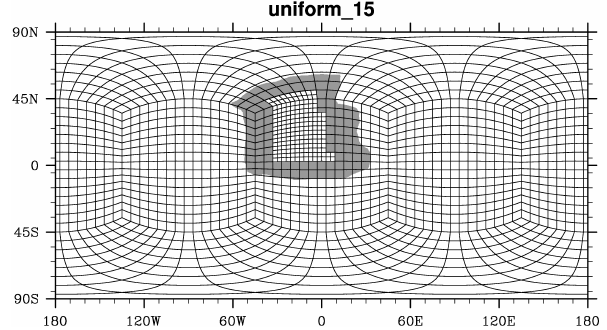
Figure 2. Schematic idea of constructing refined grids for the con- formation of quadrilaterals on a sphere: we start from uniform grid with (cid:49)x low . Next, the region of desired refinement is replaced with uniform elements of size (cid:49)x high . The grey area approximately defines a transition region, which is constructed by substituting quadrilaterals with (cid:49)x low by transition templates. After the tran- sition region is assembled, spring dynamics can be used to smooth the grid.